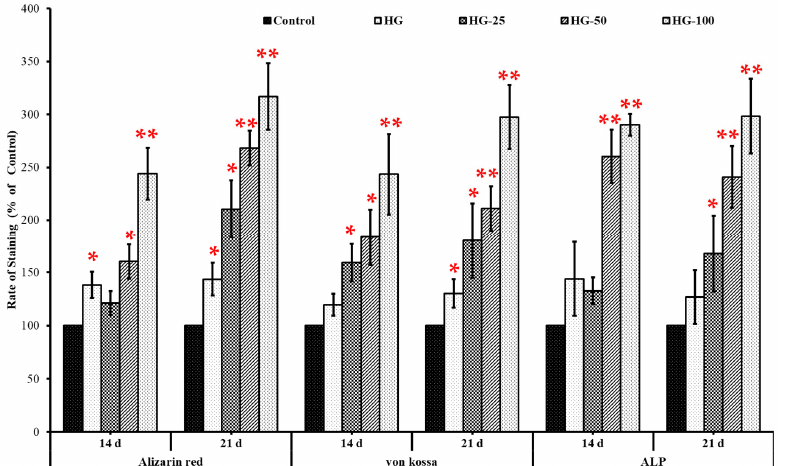
Figure 8. Quantification of the stained area of differentiated bone marrow mesenchymal stem cells cultured on hydrogels. The percentage of stained area in osteogenic cells was quantified using ImageJ software (Version 1.52n). Control—cells without hydrogel, HG—hydrogels without VEGF, HG-25, HG-50, and HG-100—hydrogels with 25 ng/mL, 50 ng/mL, and 100 ng/mL of VEGF, respectively. ALP-alkaline phosphatase. * p < 0.05 vs. control, ** p < 0.01 vs. control. Unlike mineral staining, the cells cultured for 14 and 21 days without osteogenic culture medium and osteogenic supplements showed slight positive staining for ALP and the rate of staining was increased with increasing culture time from 14 to 21 days (Figure 9). Surprisingly, the cells expressed more ALP level in VEGF-loaded HGs compared to control and expression level was more pronounced in cells cultured on high VEGF-loaded HGs compared to other VEGF-loaded HGs and control HGs.